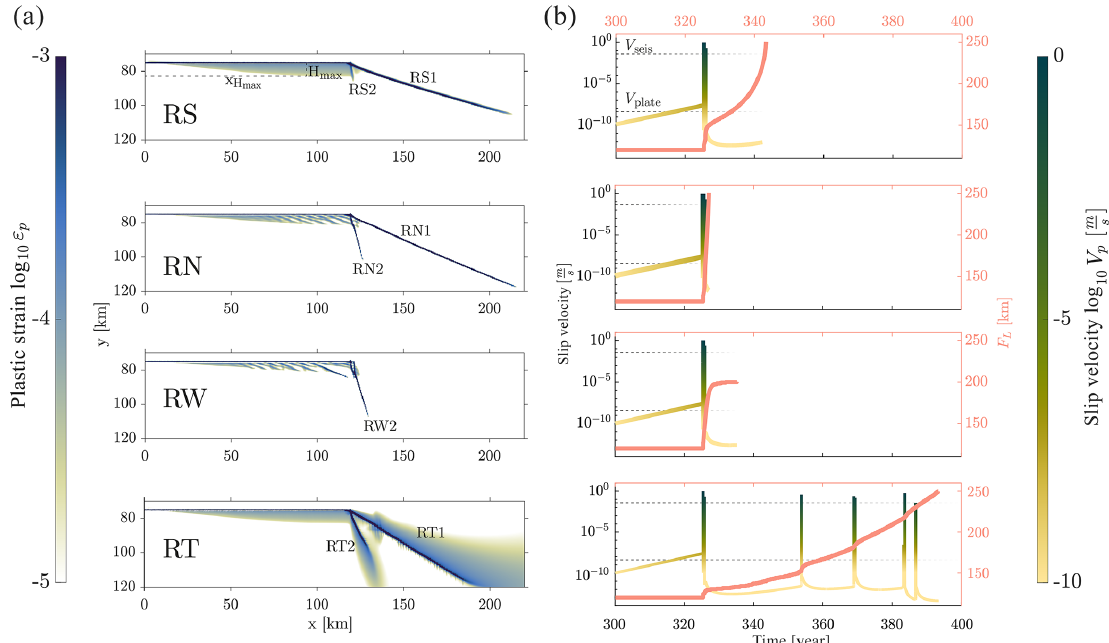
Figure 3. Summary of four different right-lateral reference models. (a) Simulation results in the form of a plastic strain pattern. RS: rate strengthening, RN: rate neutral, RW: rate weakening, RT: transition from RS to RW. R*1 indicates a Riedel fault (lower strike angle), and R*2 refers to the conjugate Riedel fault (R (cid:48) ) with a higher strike angle compared to the R1 Riedel shear. The snapshots in (a) are chosen to have approximately the same deformation stage with regard to fault length R*1. Model RW constitutes an exception as RW1 remains very short (1.8km; see the main text). (b) Temporal evolution of the plastic slip velocity V p inside the fault at (x,y) = (100, 75km) until the end of the simulation. The seismic threshold velocity is indicated as V seis . The red line shows the fault length F L over